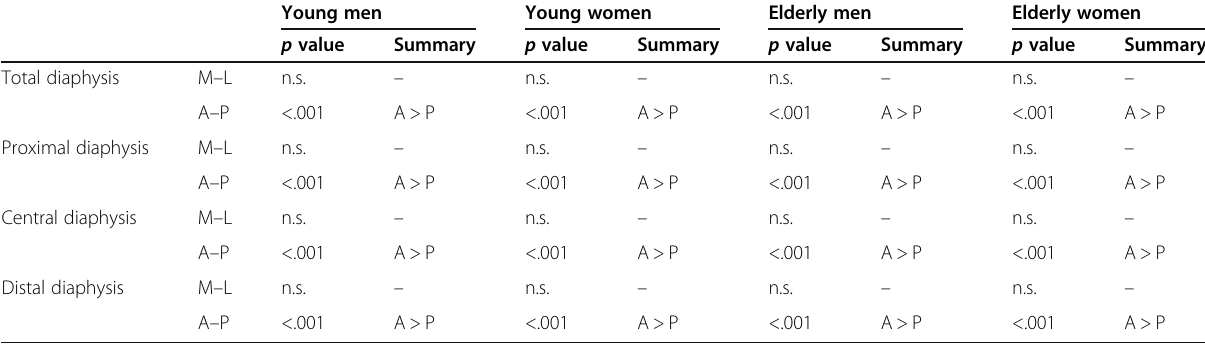
Table 3 Comparison between medial and lateral or between anterior and posterior standardized